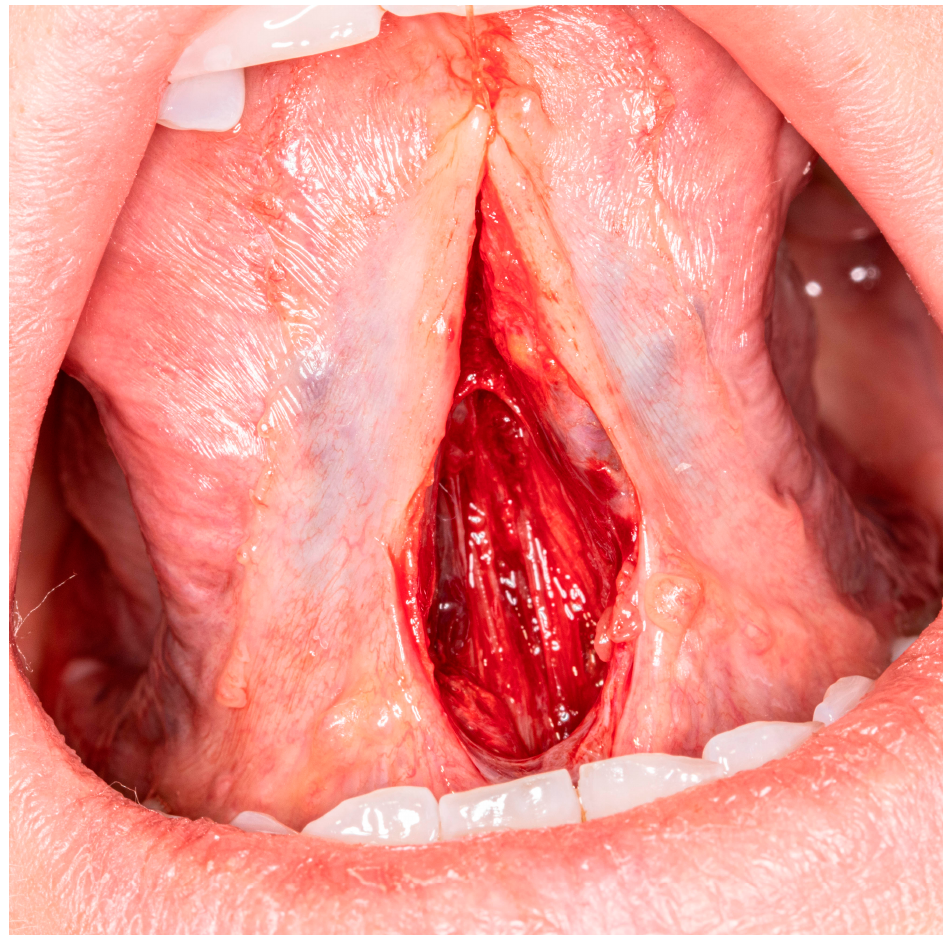
Figure 3. Fully released anterior fibers of genioglossus muscle .